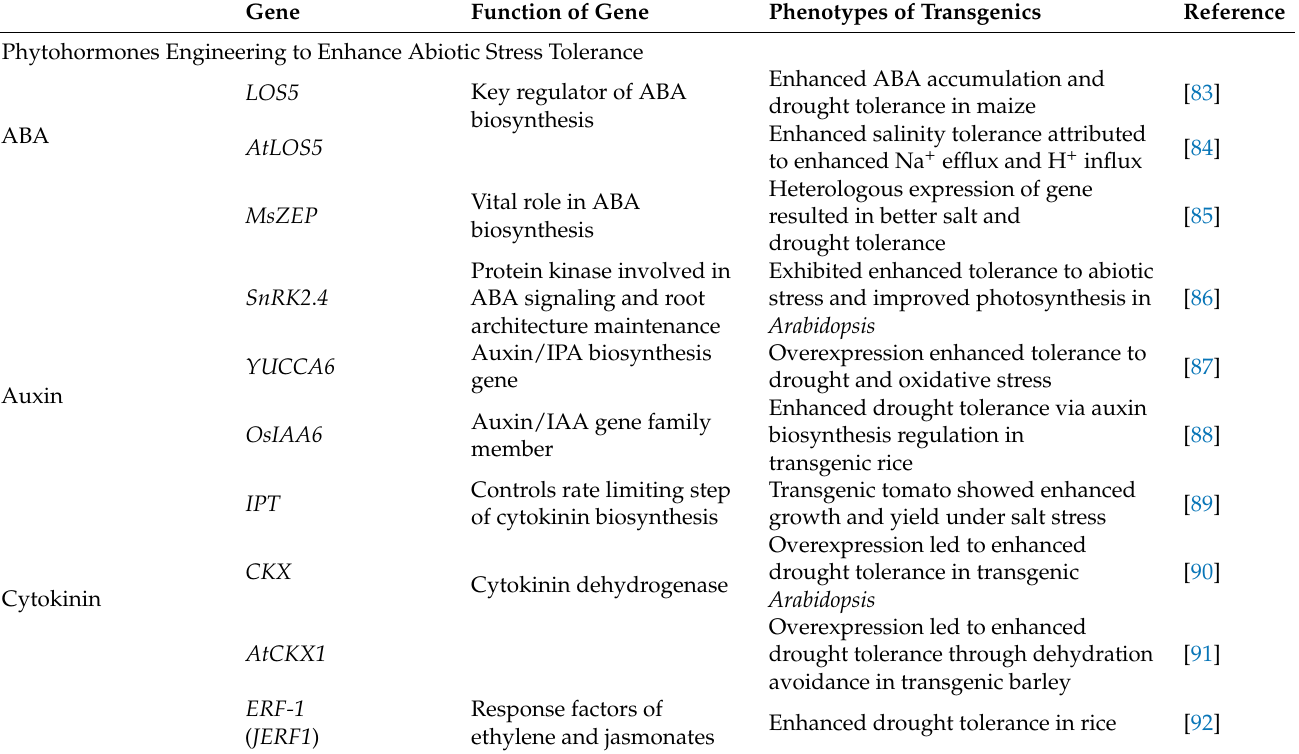
Table 2. Metabolic engineering towards enhancing performance of plants. Gene Function of Gene Phenotypes of Transgenics